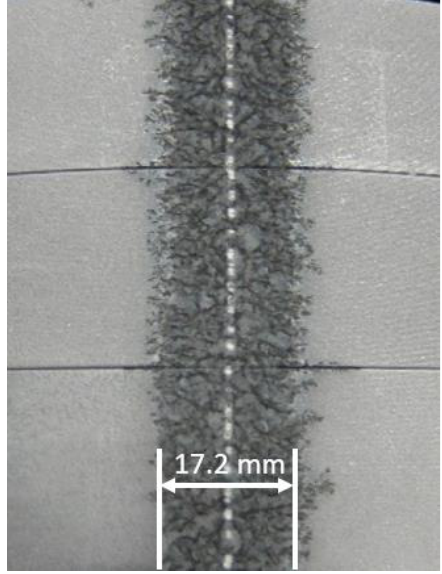
Figure 7. Example of traces of arc spots on graphite cathode surface with an arc current of 1600 A. The calculated lateral arc spot movement length is 17.2 mm.